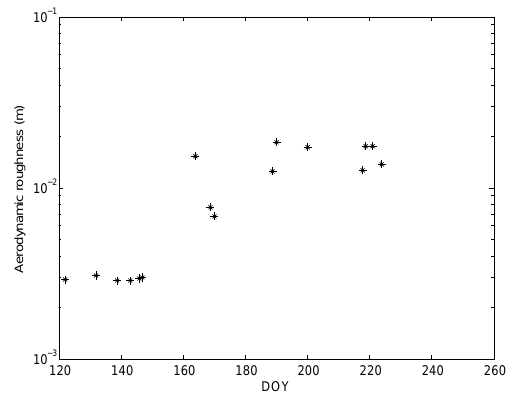
Fig. 3. Daily average sensible heat estimated by EnKF final analysis and true field (RMSE=17Wm − 2 ).